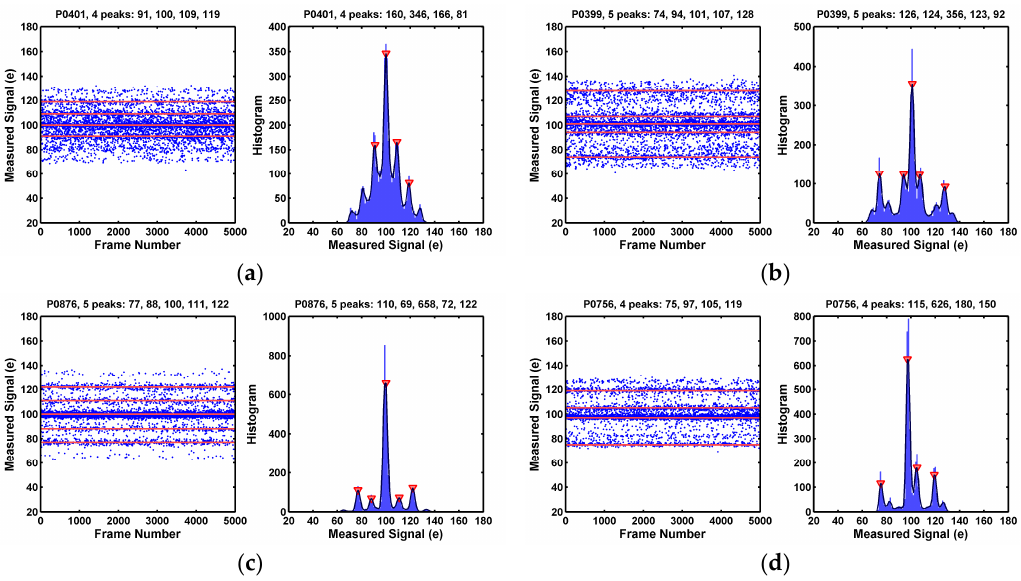
Figure 10. ( a – d ) Four example pixels showing more than 3 peaks. These pixels have more than one RTN traps. The pixel in ( a ) appears to show 7 peaks but the peak-finder program identified only 4; The pixel in ( b ) appears to show 9 peaks but the peak-finder program identified only 5. The total number of pixels showing more than 3 peaks is a small percentage of the total 8.3M population, in the order of 5~10 ppm.